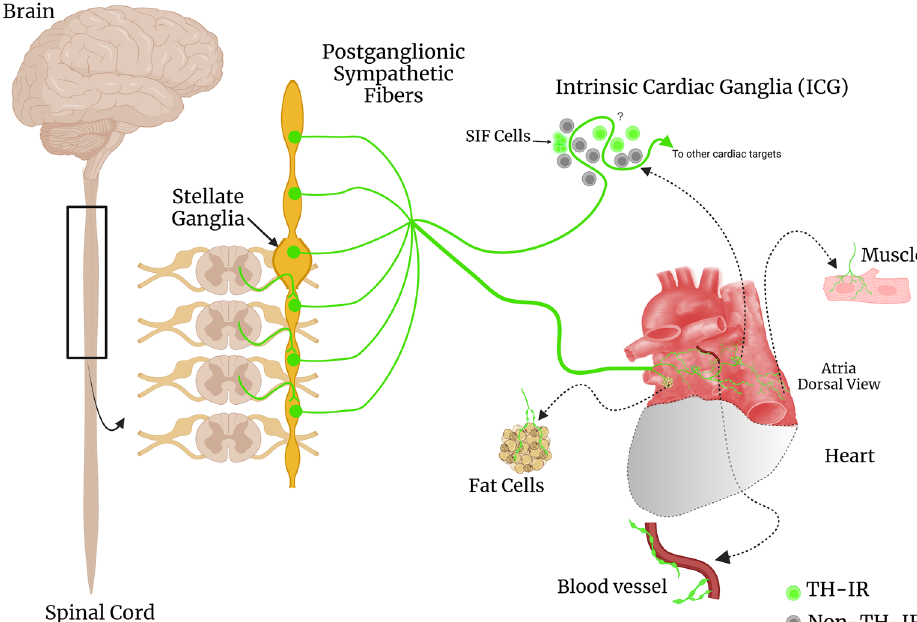
about ~ 30% of ICG neurons. The presence of varicosities around TH-IR ICG neurons and whether there is direct innervation remains to be determined in the future (indicated by question mark). (Created by Ariege Bizanti with Biorender (2022), https:// biore nder. com/